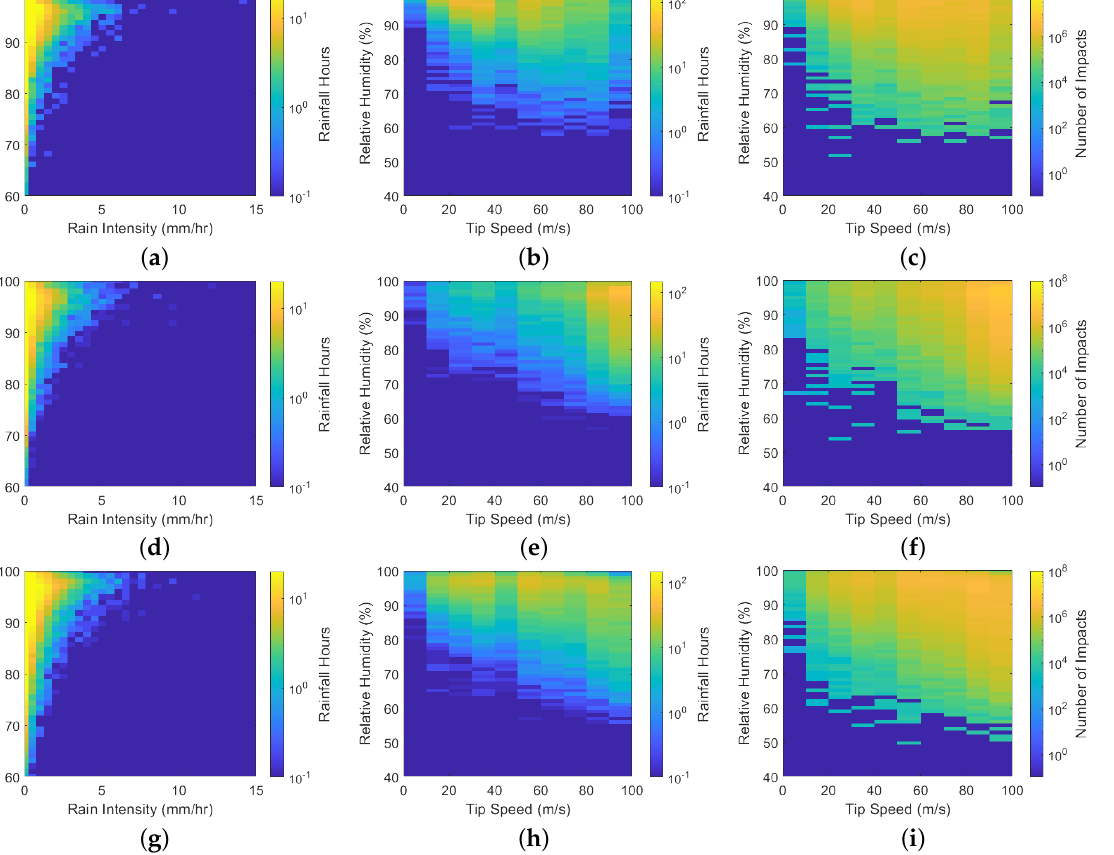
Figure 20. Average annual humidity/rainfall ( a – c ), humidity/rainfall/tip speed ( d – f ) and humidity/ n A /tip speed ( g – i ) distributions for the stations A, MA and N,